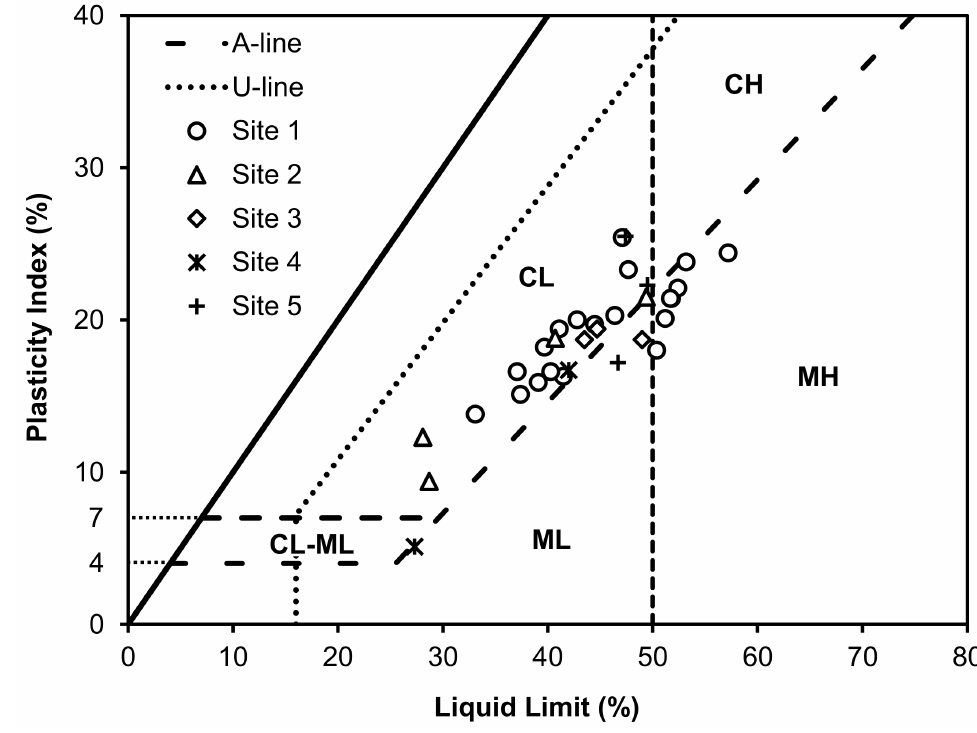
Figure 3. Plasticity chart for the